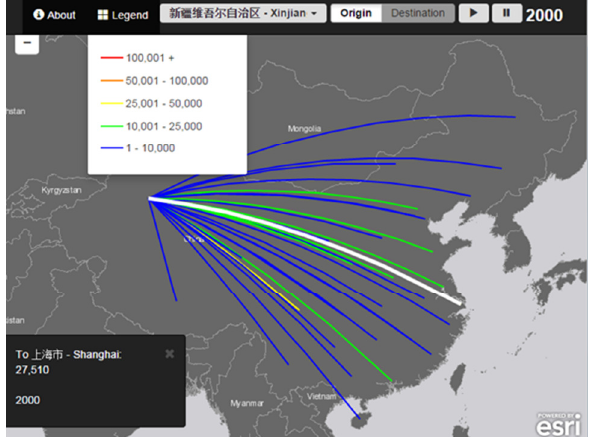
Figure 7a Migration out from Xinjiang to Shanghai in 2000